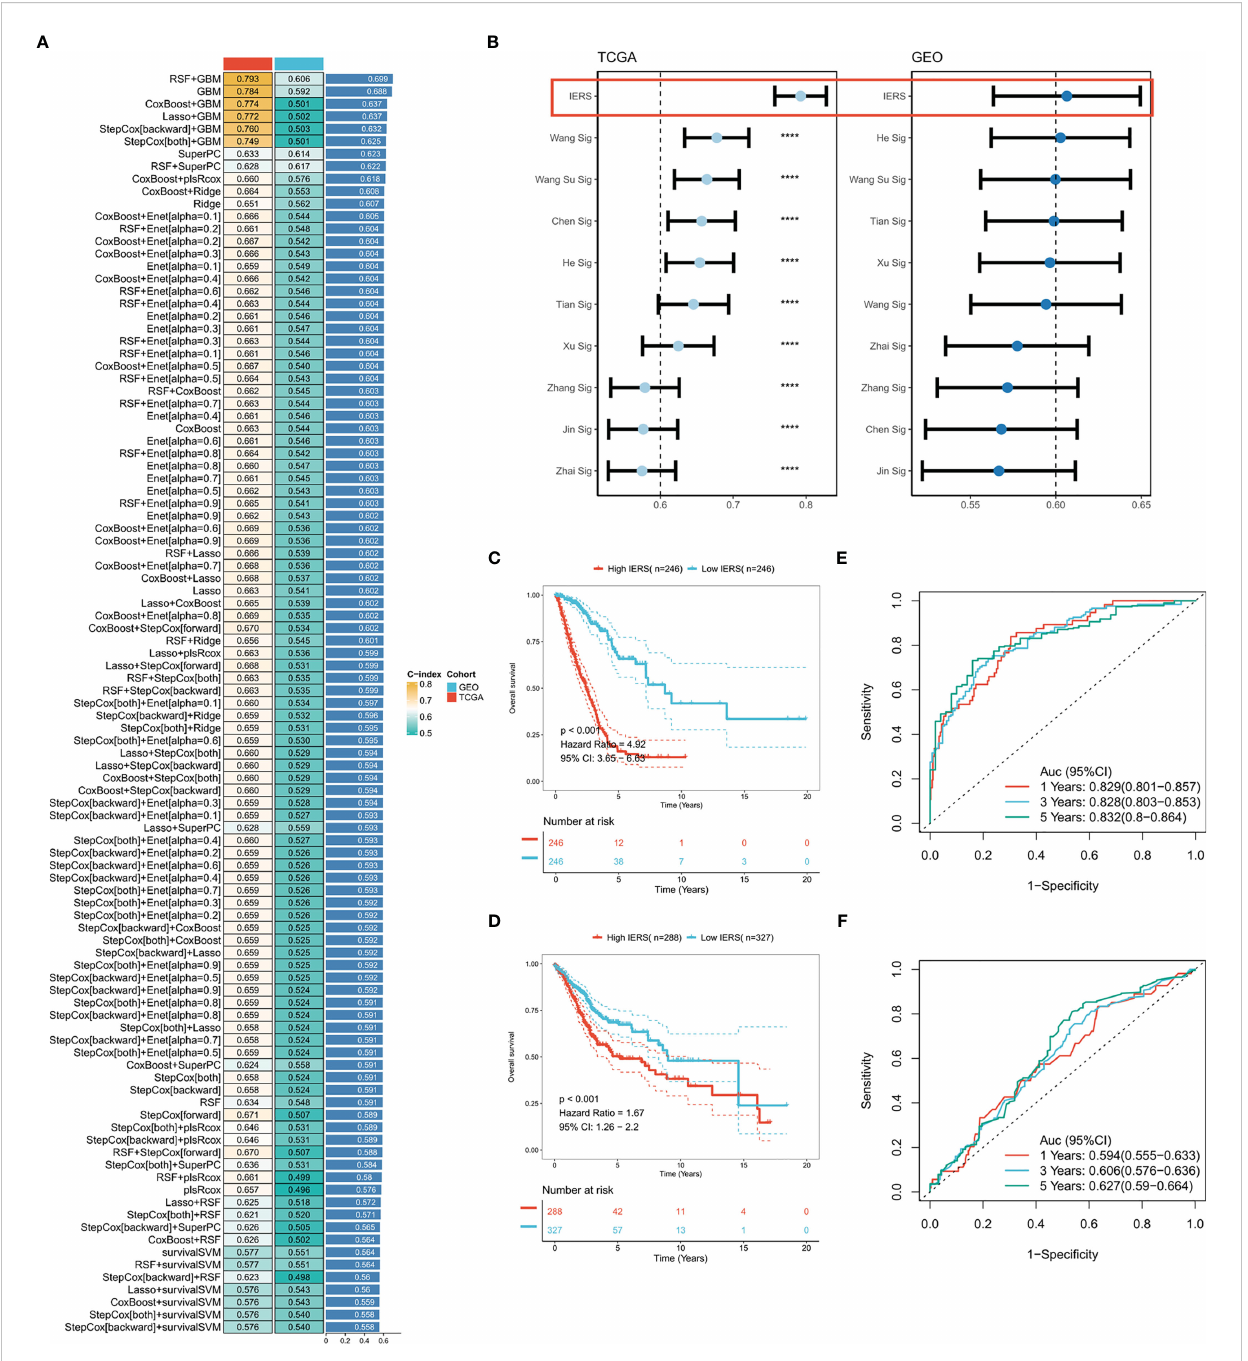
FIGURE 2 Systematic integration of machine learning algorithms to construct IERS (A) C index was calculated after cross-validation for a total of 101 algorithm combinations in both TCGA and GEO cohorts. (B) Comparing the accuracy of IERS with 10 published molecular signatures. (C) KM survival curves for the high-IERS and low-IERS groups in the TCGA cohort. (D) KM survival curves for the high-IERS and low-IERS groups in the meta-GEO cohort. (E) 1-, 3-, and 5-year ROC curves for IERS in the TCGA cohort. (F) 1-, 3-, and 5-year ROC curves for IERS in the meta-GEO cohort.